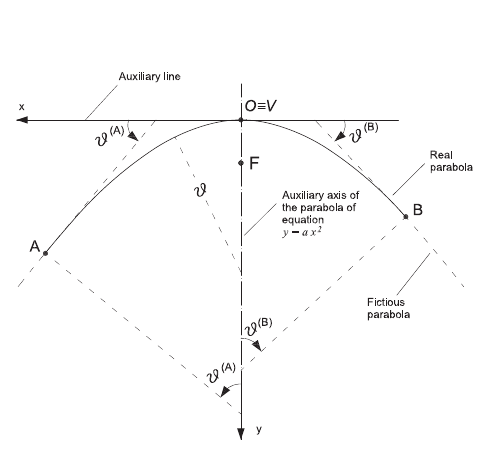
Figure A1: Parabolic arch referred to a global reference